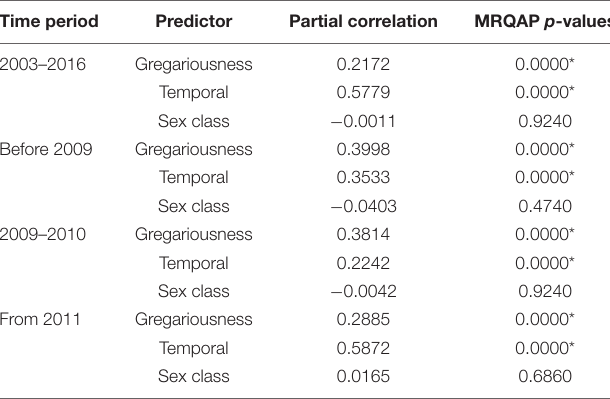
TABLE 2 | Efficiency of predictor variables in explaining association indices between bull sharks, indicated by partial correlation coefficients and results of multiple regression quadratic assignment procedures test